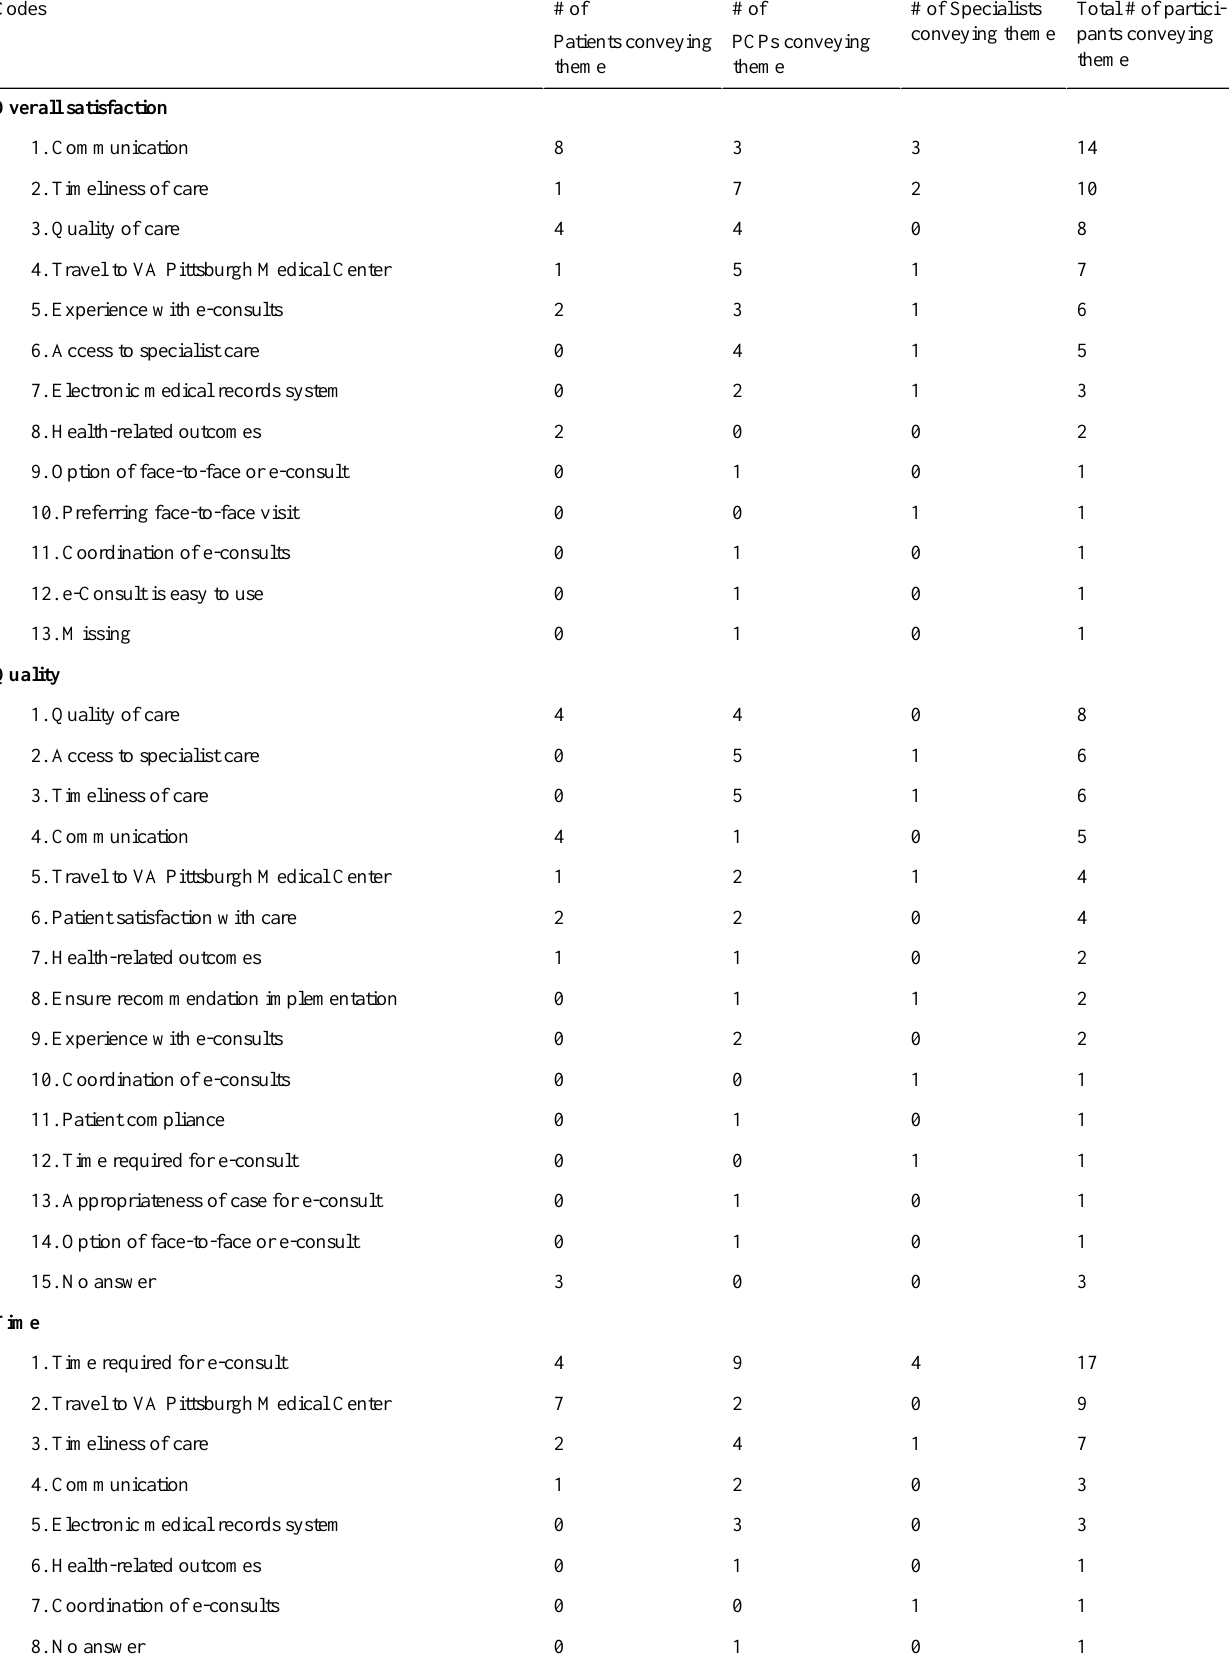
Table 3. Codes and frequencies for e-consult satisfaction domains identified during interviews with 15 patients, 15 PCPs, and 4 specialty physicians who utilized the e-consult process.